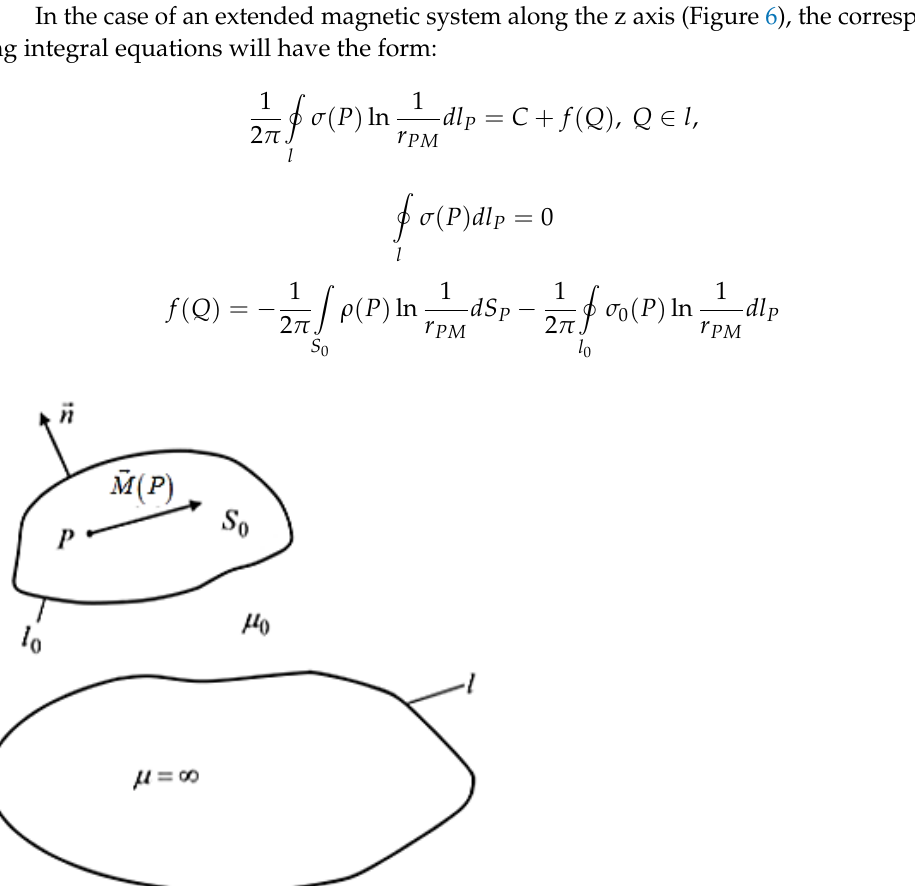
Figure 6. Field of a permanent magnet, plane-parallel case, under the condition of a magnetic system extended along the z axis.